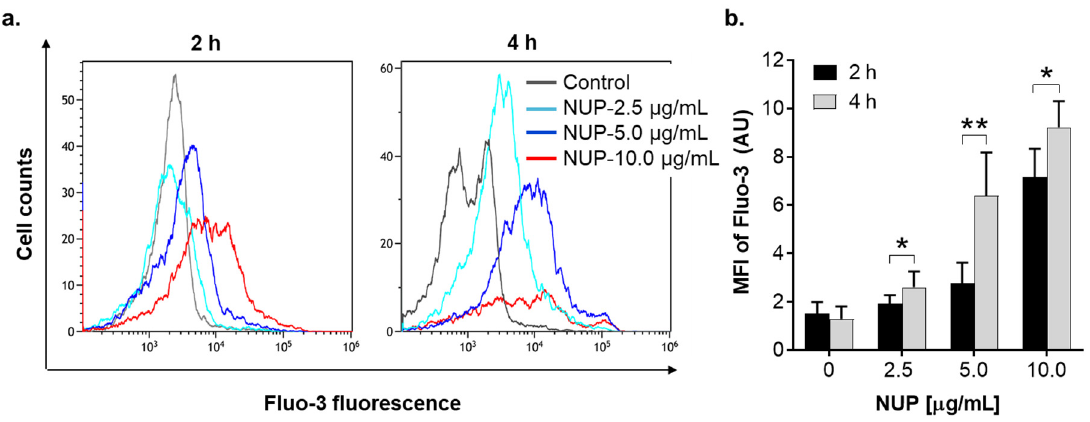
Figure 7. Sustained elevation of Ca 2+cyt in NUP-treated HL60 cells. Cells were incubated with the indicated NUP concentrations for 2 h or 4 h. ( a ) Typical examples of Ca 2+ cyt measurement from a representative experiment. ( b ) Averaged relative Ca 2+cyt levels expressed as Fluo-3 geometric mean fluorescence intensity (MFI) units. The data are means ± SD of 3 independent experiments performed in duplicate. *, p < 0.1 and **, p < 0.01, significant differences between the indicated groups.